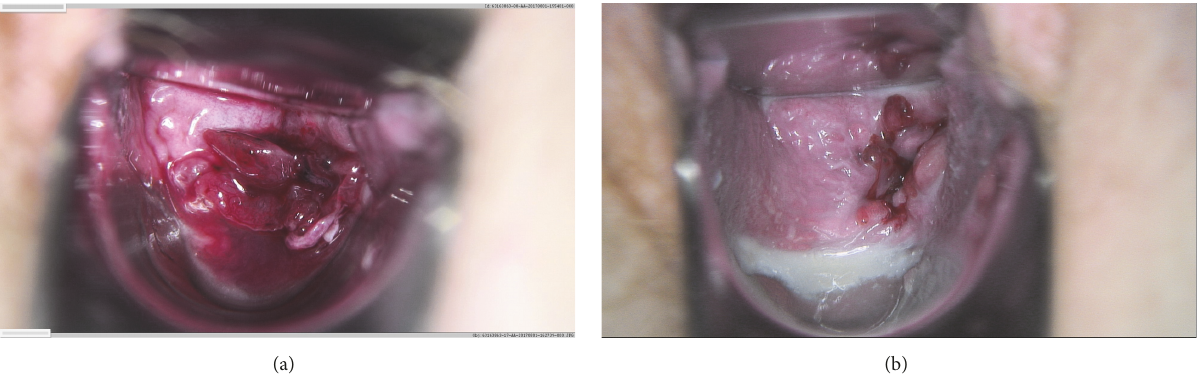
Figure 1: (a) Fresh, vulnerable, histologically confirmed rectovaginal endometriosis in the posterior fornix (Medivan video colposcope). The visual analogue score for the examination ( VAS examination ) before dienogest therapy was 9. (b) Remission of the same endometriotic lesion in the posterior fornix 3 months later after daily vaginal dienogest application. VAS examination score was now 4.